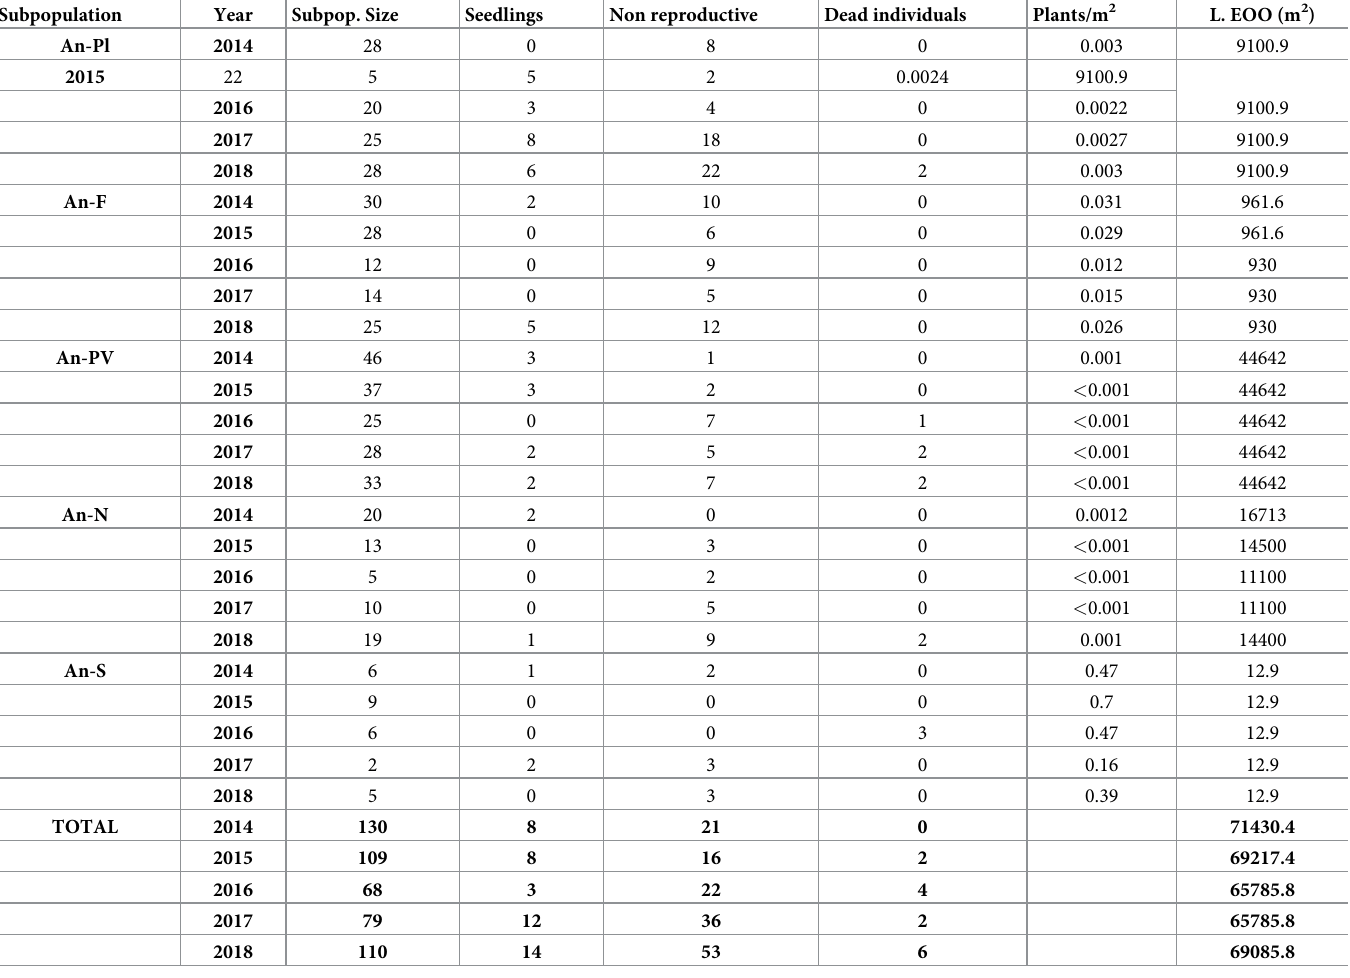
Table 2. Number of mature individuals (subpopulation size), seedlings, non-reproductive individuals and dead individuals, local EOO and plants per m 2 for each subpopulation per year.